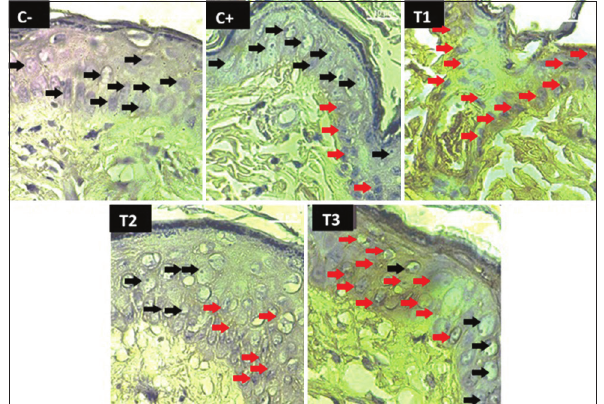
Figure-1: Caspase-3 expression in the treatments of C−, C+, T1, T2, and T3. ( → ) The black arrow shows the normal skin epithelial cell, ( → ) the red arrow shows the caspase-3 expression of skin epithelial cell.